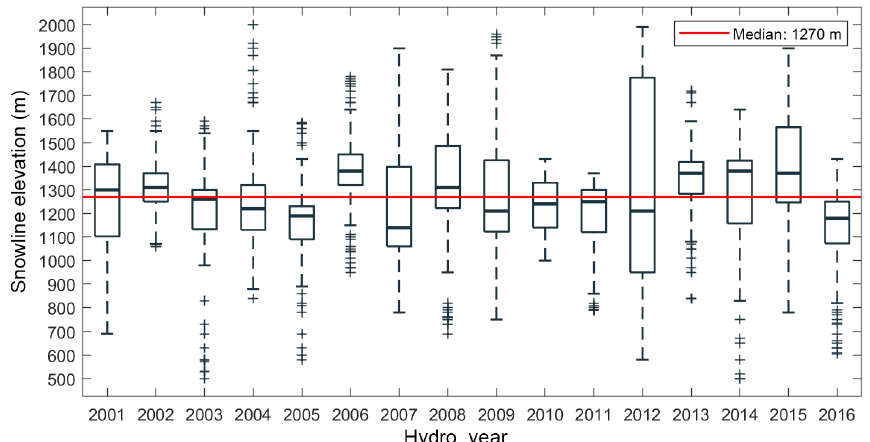
Figure 10. Box plots of winter (1 June–30 September) snowline elevation for all years. The upper and lower bounds of the boxes are the 75th and 25th percentiles, respectively. Outliers are represented by “ + ” symbols.